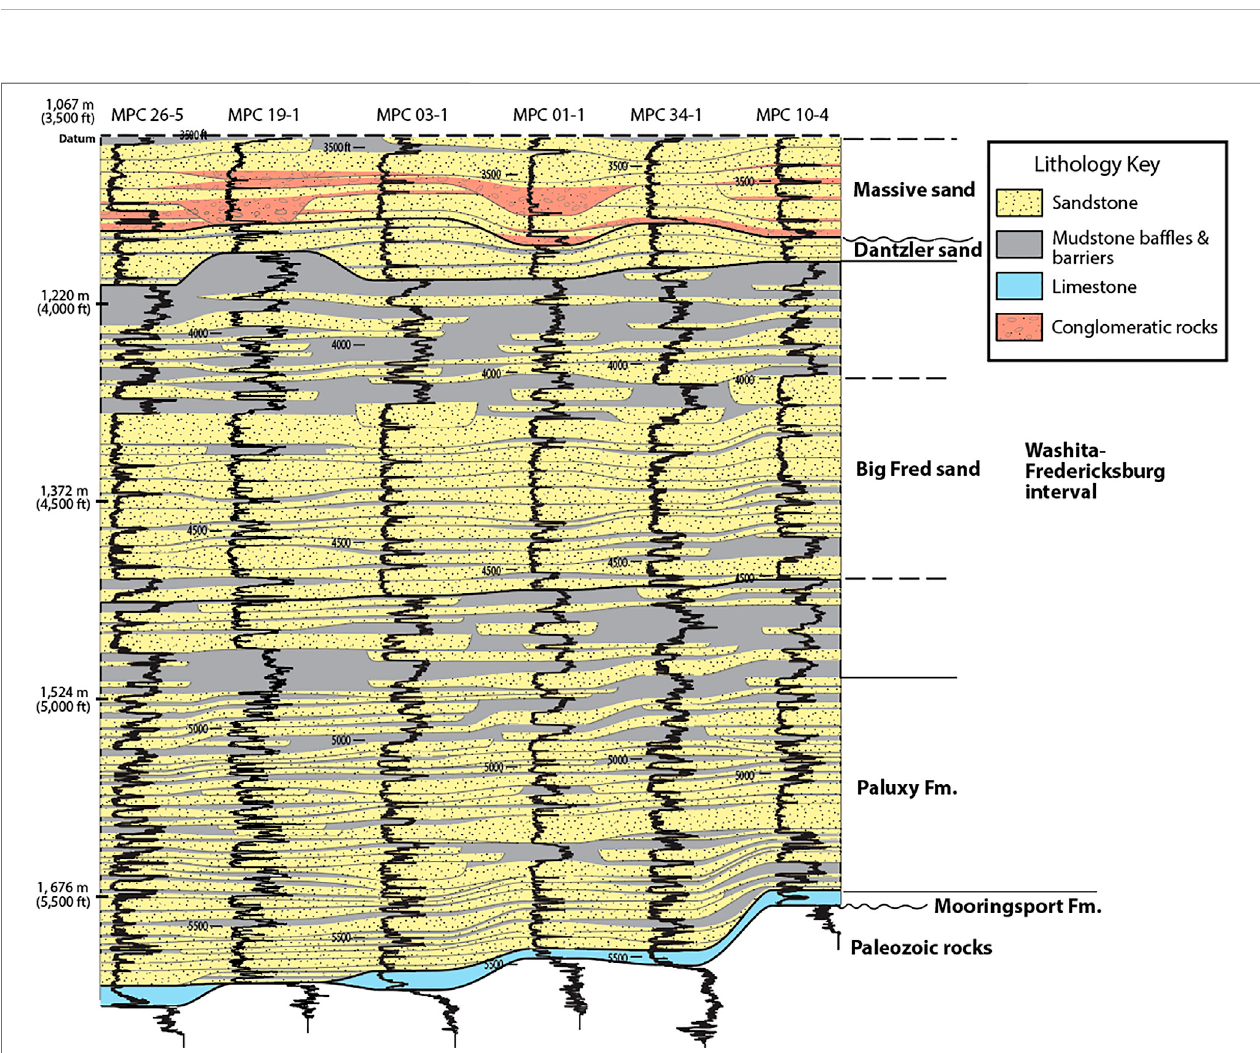
FIGURE 3 | Stratigraphic cross section showing correlation of Paluxy and Washita-Fredericksburg strata using gamma logs (after Pashin et al., 2021).